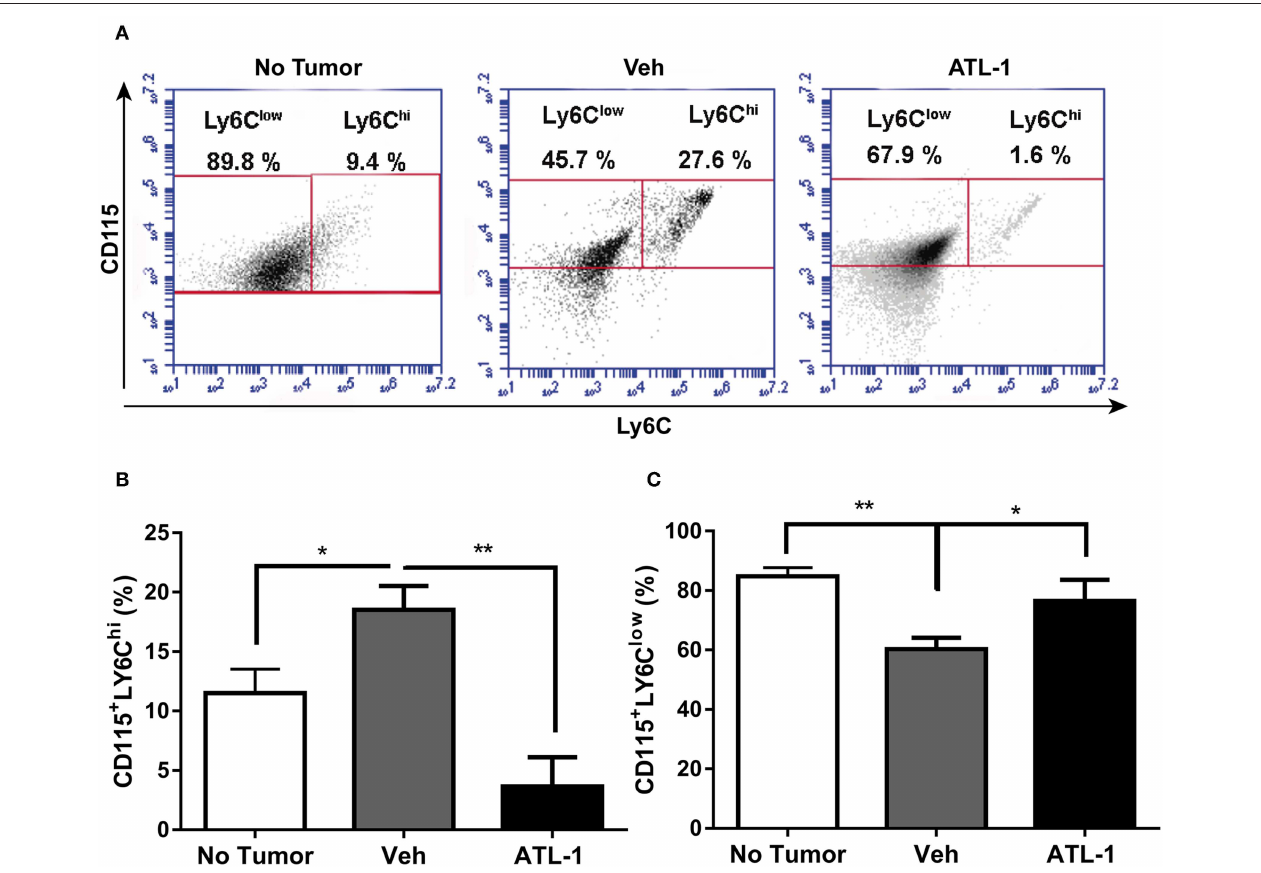
FIGURE 4 | ATL-1 treatment decreases blood circulating CD115 + LY6C hi monocyte population of tumor-bearing mice. C57/BL6 mice were inoculated with B16/F10 tumor cells. After 14 days, ATL-1 (1 µ g/animal) or vehicle (20 µ L ethanol) was administered. On 21st day, the animals were anesthetized, and blood was withdrawn by cardiac puncture. Thereafter, monocytes were isolated from the blood for further labeling with specific antibodies for flow cytometry analysis. (A) Representative dot plot used to quantify the percentage of CD115 + /LY6C hi and CD115 + /LY6C low populations within the selected gate. (B) CD115 + LY6C hi ( n = 5–6); (C) CD115 + LY6C low ( n = 5–6). Data are expressed as mean ± SEM. * p < 0.05; ** p < 0.01 by unpaired t -test or ANOVA test, followed by Bonferroni test.